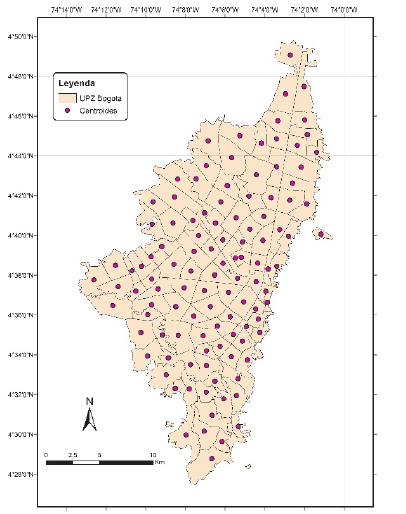
Fig. 2. Zonal Planning Units for the city of